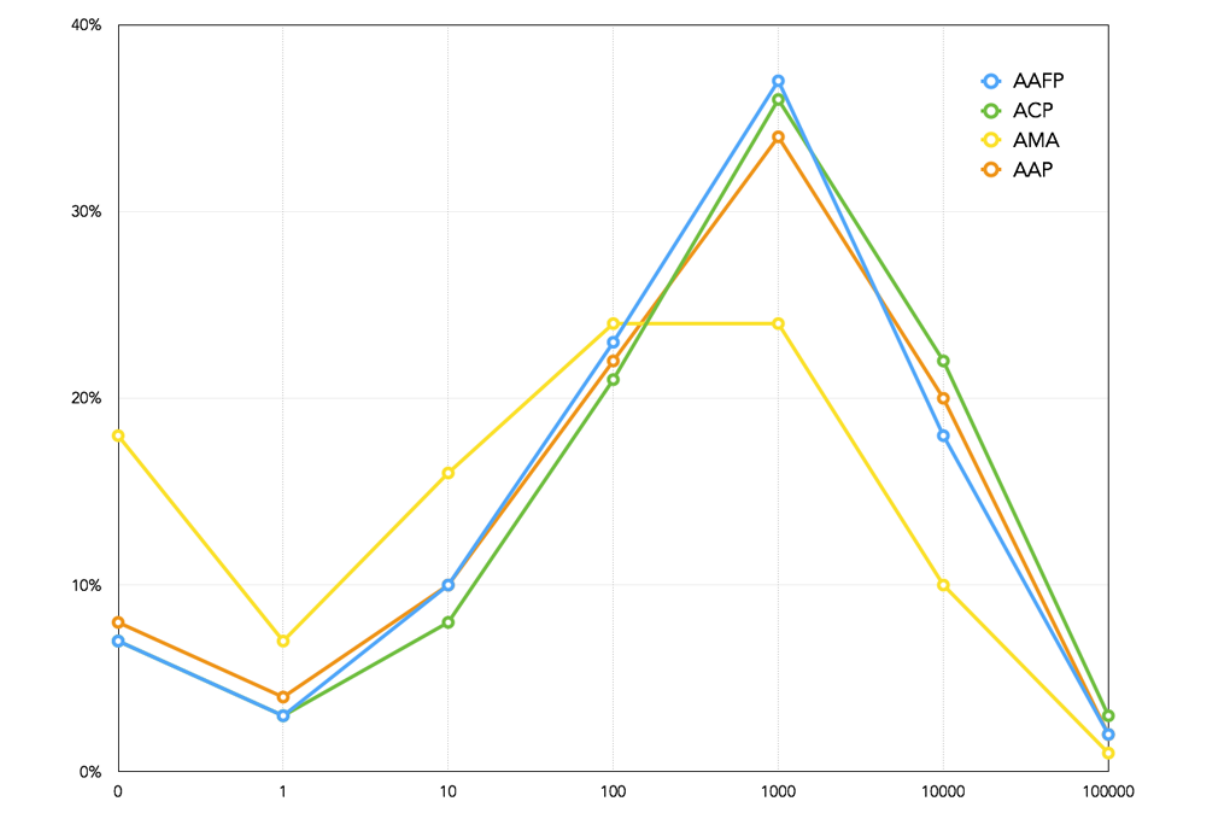
Figure 4. Number of tweets/retweets sent by followers of the four professional groups - American Medical Association (AMA), American